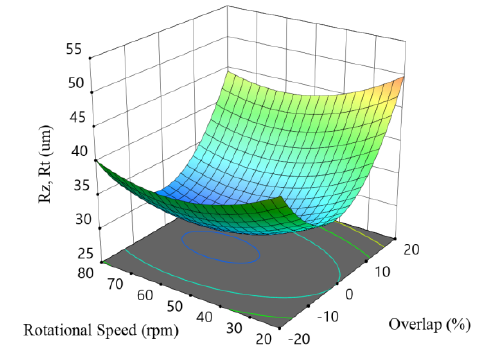
Figure 12. RSM plot correlating the R z with the processing parameters in DoE-2.